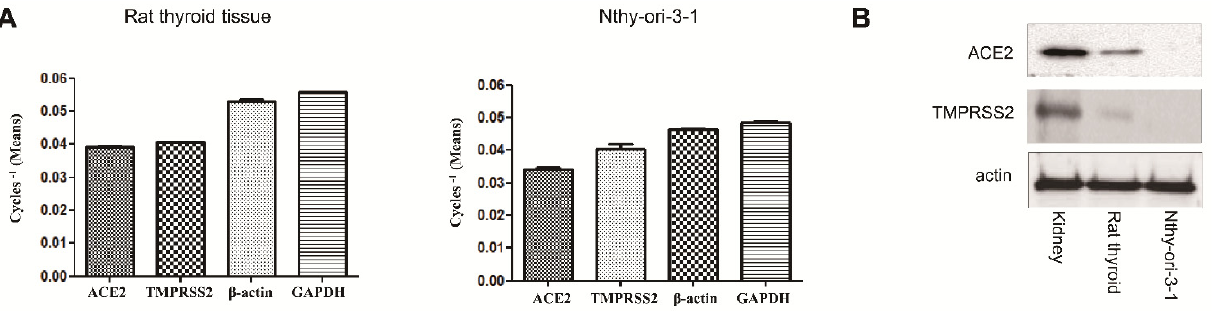
Figure 1. Expression of ACE2 and TMPRSS2 in the thyroid. ( A ) In RT-PCR, ACE2 and TMPRSS2 genes were expressed in both rat tissue and human follicular cells (Nthy-ori-3-1). The expression of ACE2, TMPRSS2, β -actin, and GAPDH are shown as means of cycles − 1 . ( B ) The Western blot revealed that protein expression of ACE2 and TMPRSS2 was detected in rat thyroid tissue, but not in follicular cells. n = 3. Columns and error bars represent the mean ± standard deviation. RT-PCR, quantitative reverse transcription–polymerase chain reaction; ACE2, angiotensin-converting enzyme 2; TMPRSS2, transmembrane protease serine; GAPDH, glyceraldehyde 3-phosphate